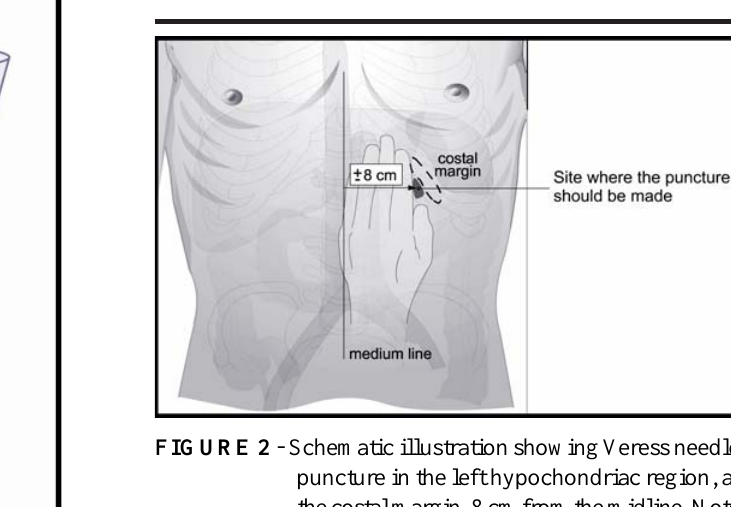
FIGURE 2 - Schematic illustration showing Veress needle puncture in the left hypochondriac region, at the costal margin, 8 cm from the midline. Note the entry point of the needle and the distance from the great vessels.